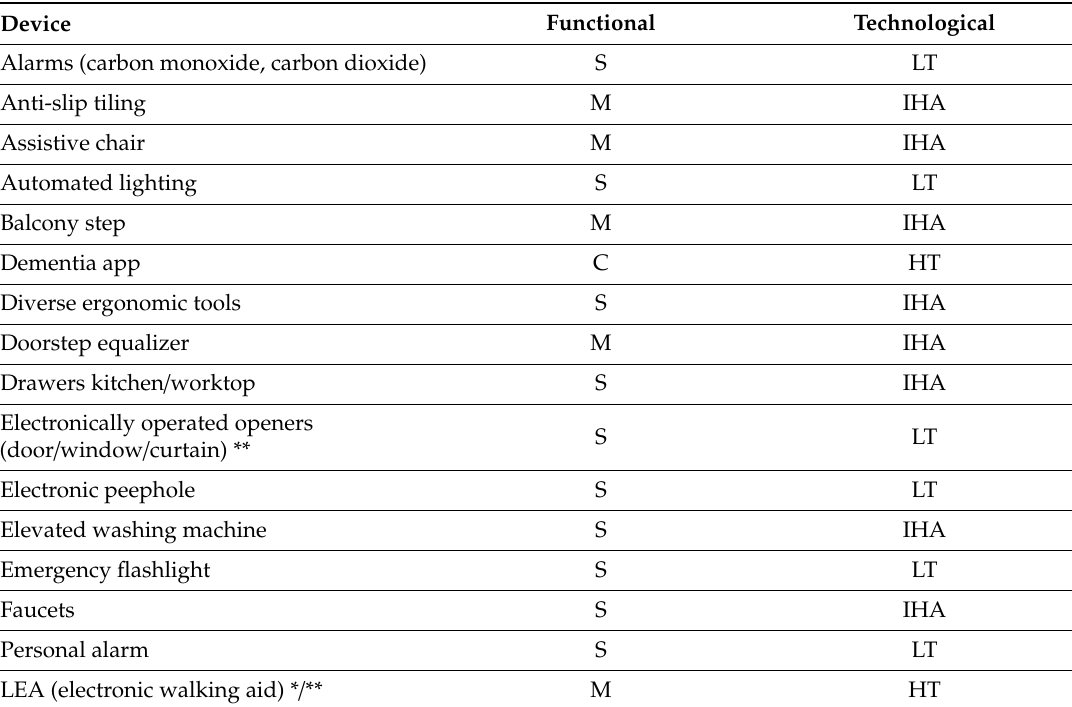
Table B1. Available items in study and their classification. Table A1. Available items in study and their